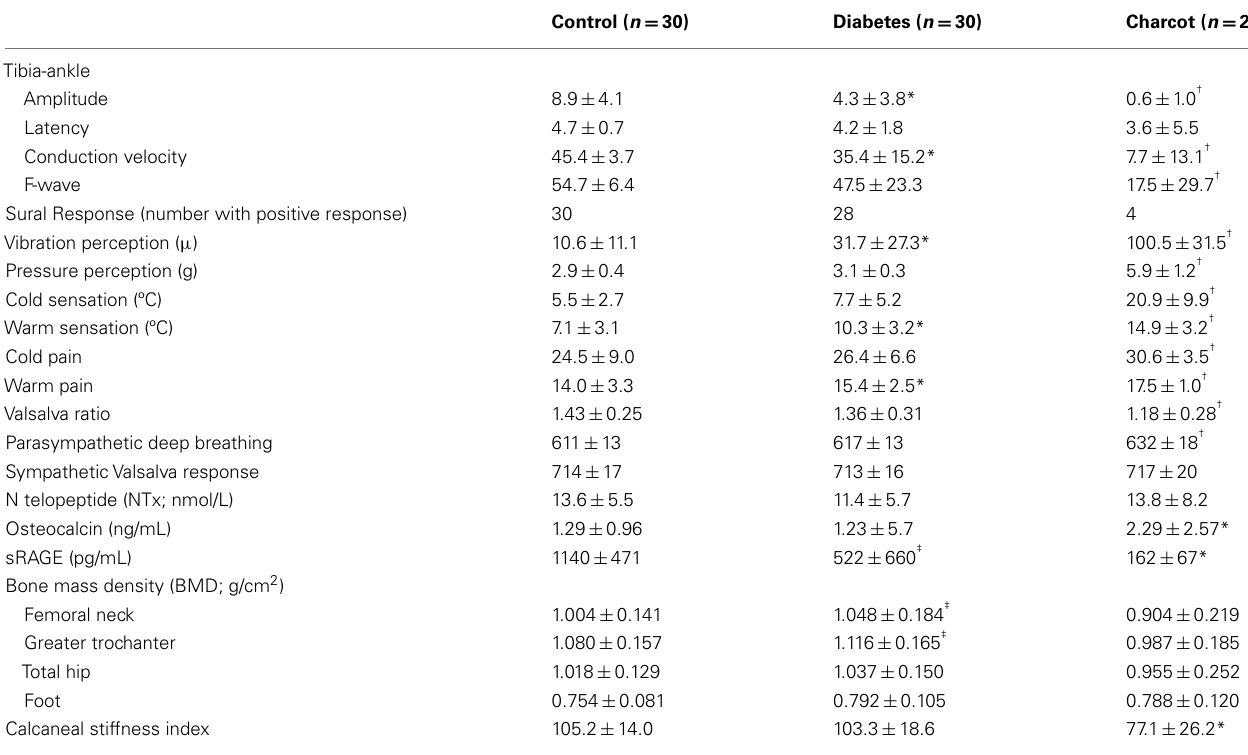
Table 1 | Peripheral and autonomic nerve dysfunction and reduction of sRAGE in diabetes and Charcot neuroarthropathy (mean ±